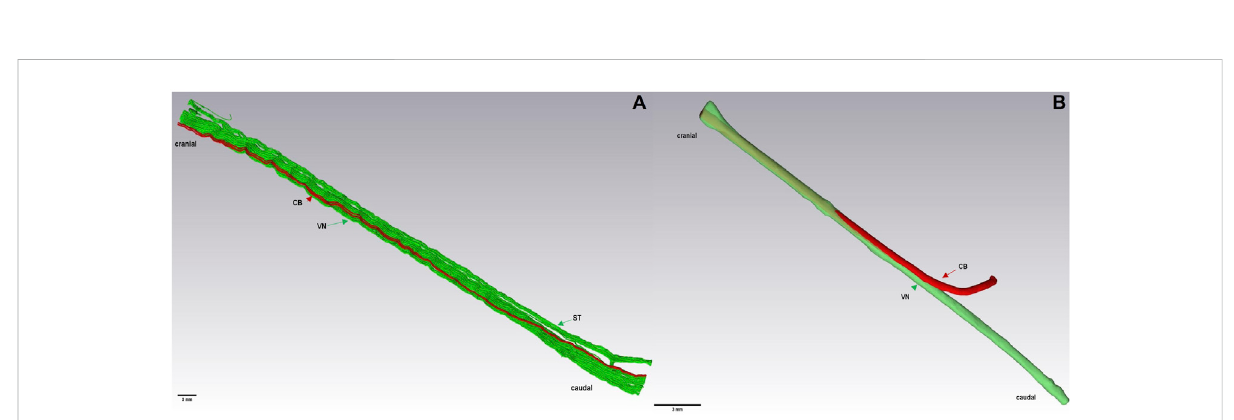
FIGURE 4 3Drenderingofacaudalnervespecimen(7 cm)oftheVN,ST,andCBatthelevelofthecardiacbranchingpointinapig (A) andoftheVNandCB ina rabbit (B) , respectively. Here, the STtravels closely adjacentto the VN. Green: fasciclesof theVN and ST. Red: cardiac branch fascicle. VN, Vagus Nerve; CB, cardiac branch; ST, Sympathetic